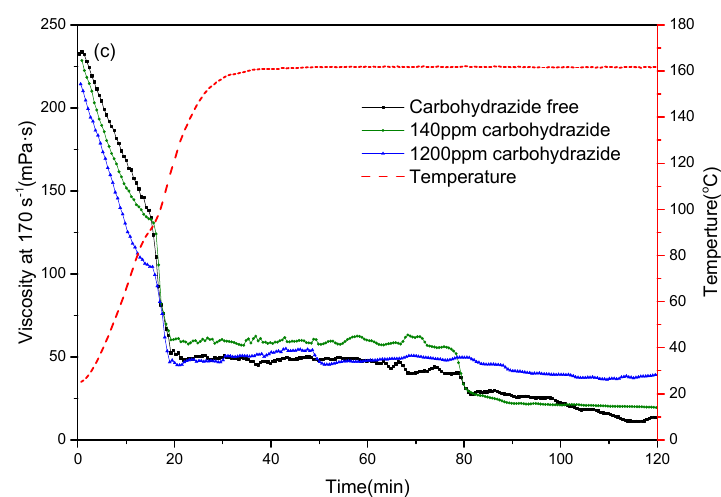
Figure 7. Effect of environmentally-friendly deoxidizer ( a ) acetone oxime; ( b ) sodium erythorbate; and ( c ) carbohydrazide on solution thermal stability of PAANM (10% NVP) solution.